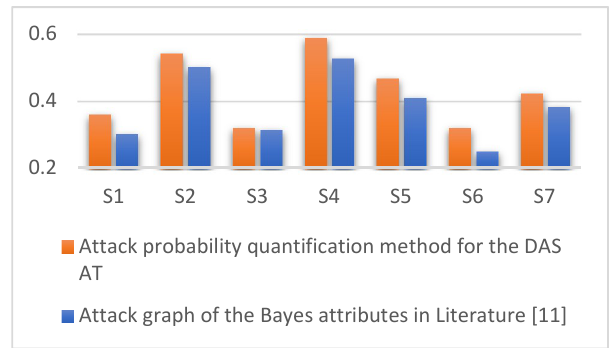
Figure 7. Comparison of the attack path probability for the DAS cases.